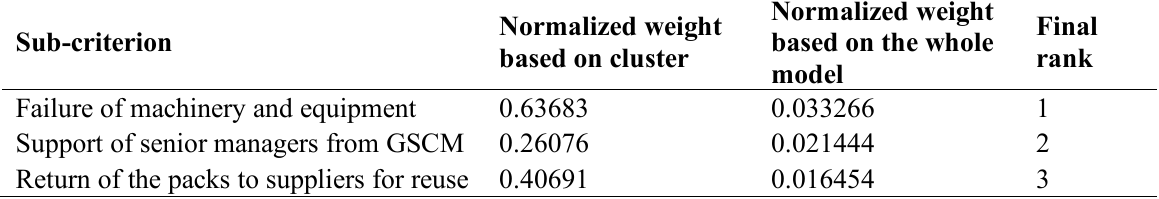
Table 2. Ranking the greenness and risk sub-criteria of the tank construction supply chain